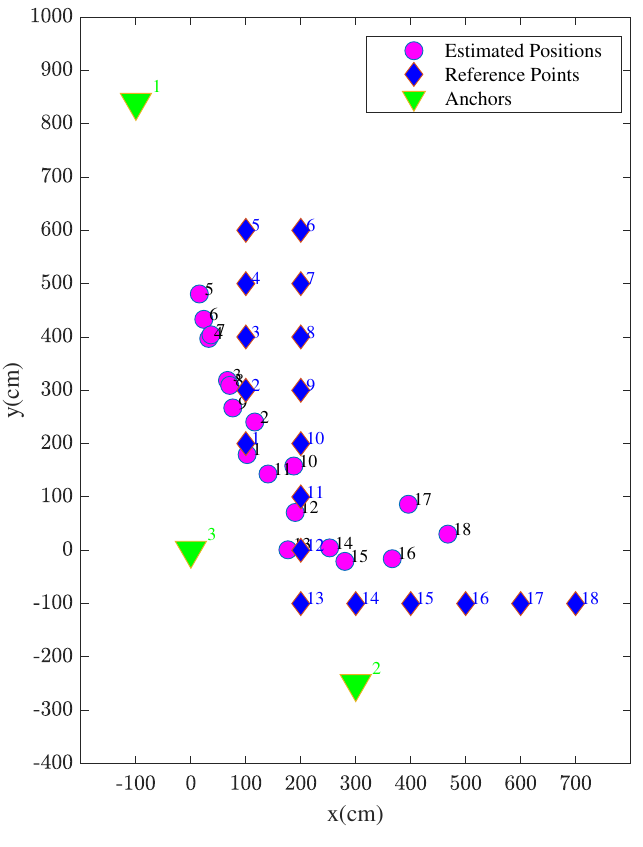
Figure 12. UE positions estimated using standalone WiFi devices.